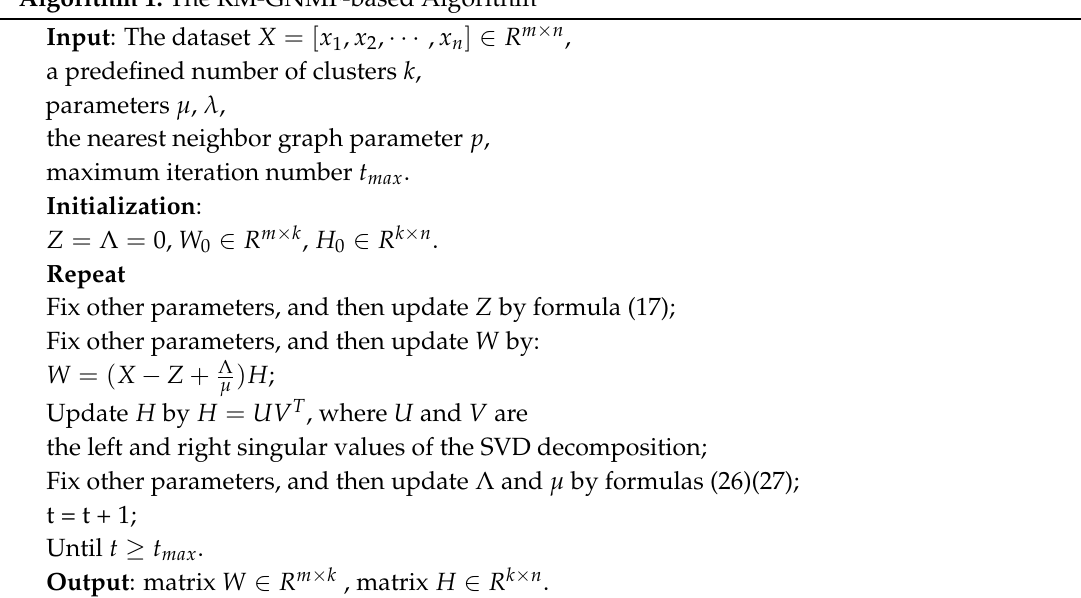
Algorithm 1: The RM-GNMF-based Algorithm